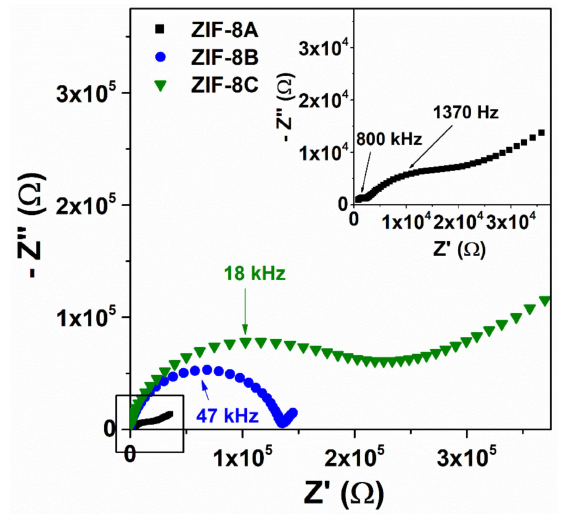
Figure 5. Nyquist plots collected at P / P 0 = 0.98 and 94 ◦ C for ZIF-8A (black squares), ZIF-8B (blue circles) and ZIF-8C (green triangles). The numbers indicate the peak